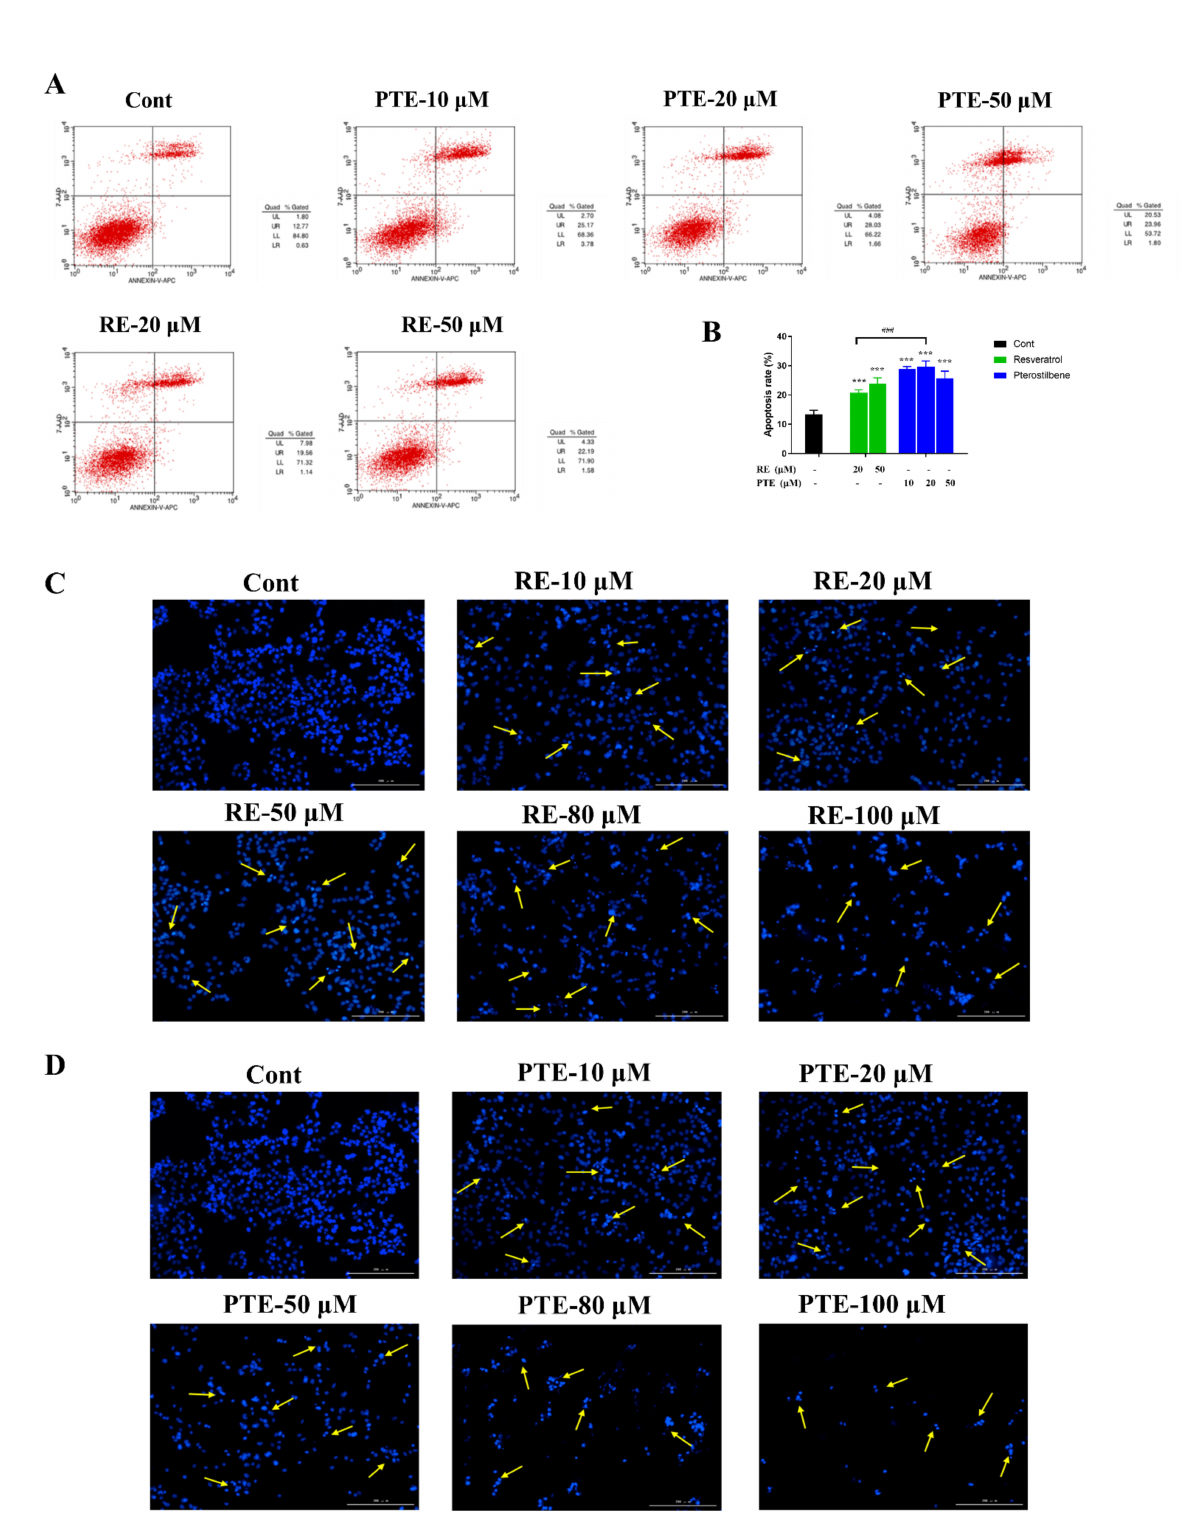
Figure 2. Apoptosis of CL187 cells treated with PTE and RE. ( A ) CL187 cells were treated with PTE or RE at different concentrations for 48 h, followed by flow cytometry. ( B ) Total apoptosis rate through flow cytometry. *** p < 0.001 vs. control. ns, not significant. Data are mean ± SD, n = 3. CL 187 cells were treated with RE ( C ) and PTE ( D ) at different concentrations for 48 h. Stained cells were observed under a multimode microplate detection and cell imaging system ( × 100). The cells with condensed chromatin and shrunken nuclei were defined as apoptotic cells, marked with yellow arrows in the